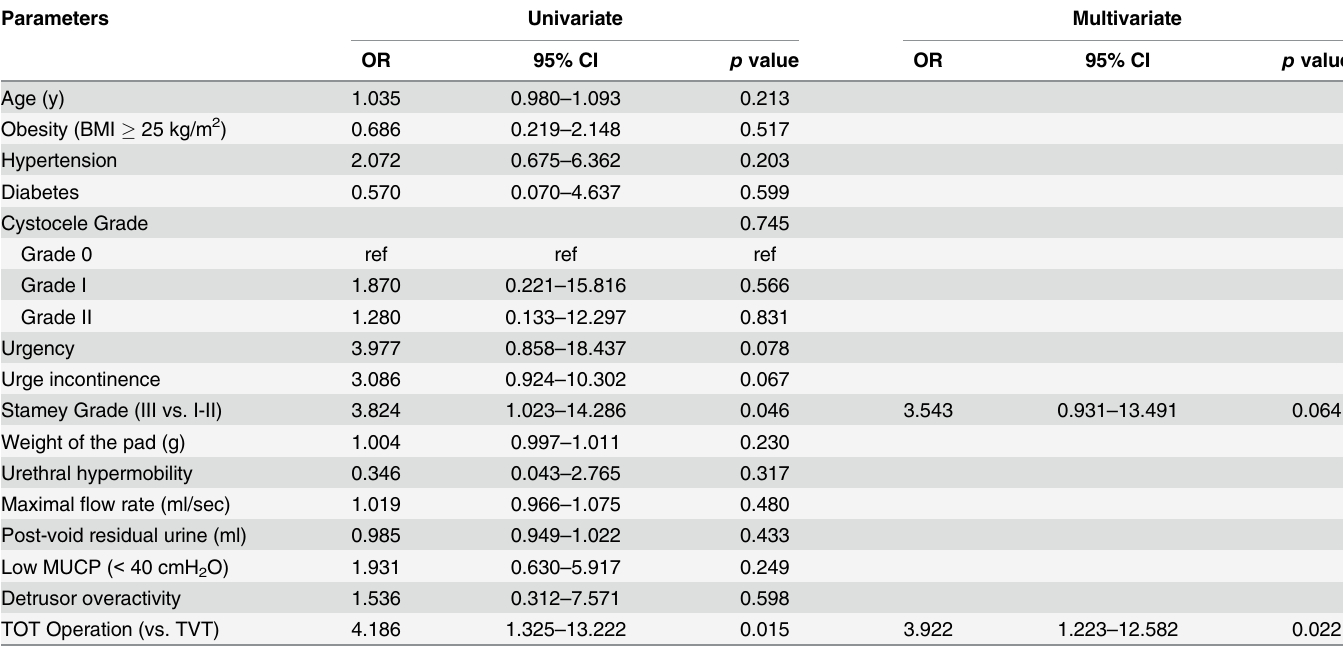
Table 2. Multivariate analysis of factors related to treatment